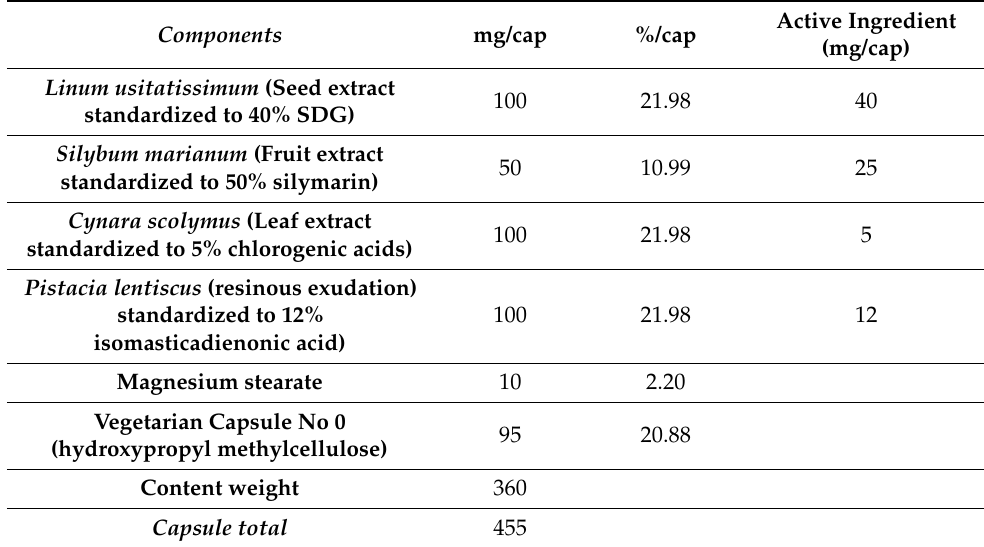
Table 1. Composition of the oral capsule that was tested in cellulo and administered in the context of a clinical trial.